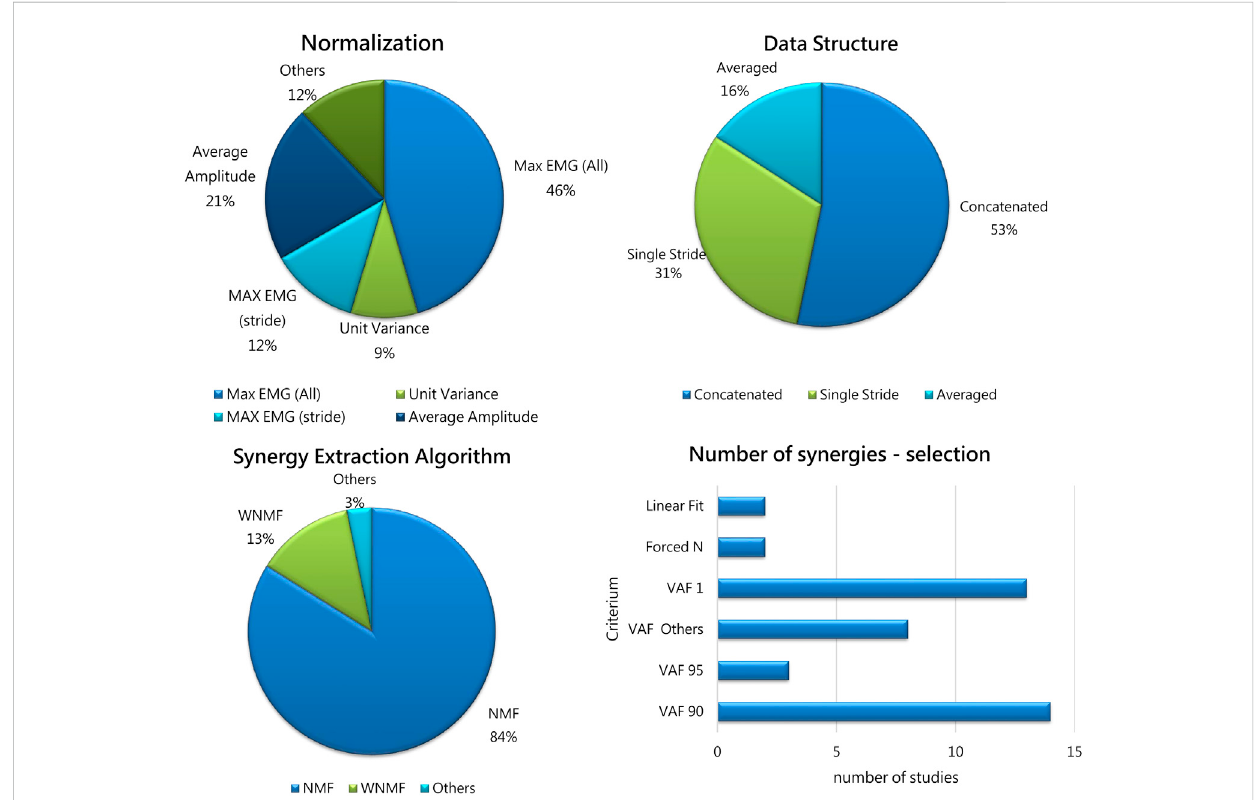
FIGURE 4 Upper-leftpanel:ThepercentageofNormalizationApproachesadoptedintheselectedstudies.MaxEMG(All):normalizationontheMaximumpre- processed EMG value on all trials; Average Amplitude: normalization on the average value for each channel; Unit Variance: normalization to achieve unit variance for each channel; Max EMG (Stride): normalization on single gait cycles; Others includes approaches used in single studies (maximum of mean value, normalized to the 95th percentile of maximum activation). Upper-left panel: Data Structure occurrences before synergy extraction: Concatenated (53%); Single Stride (31%); Averaged strides (16%). Lower-left panel: The percentage of Algorithms used in the selected studies. Acronyms: NMF: non-negative matrix factorization; WNM: weighted non-negative matrix factorization; Others: EMG cross correlation. Lower-right panel: The percentage of criteria for selecting the number of synergies used in previous studies: VAF threshold was adopted by most of the studies (almost